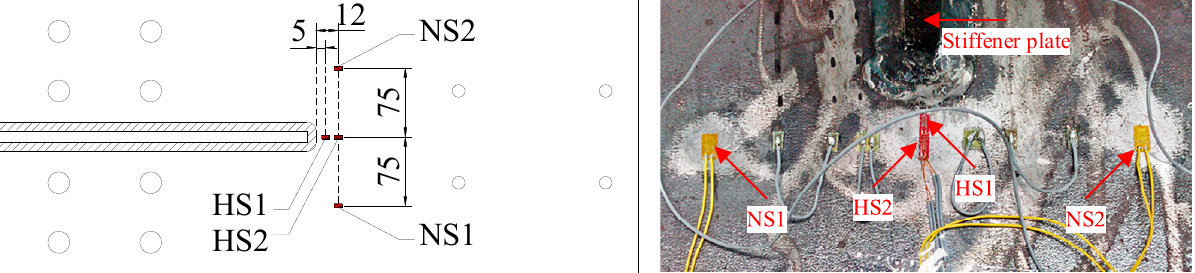
Figure 4. Arrangement of strain gauges (mm).